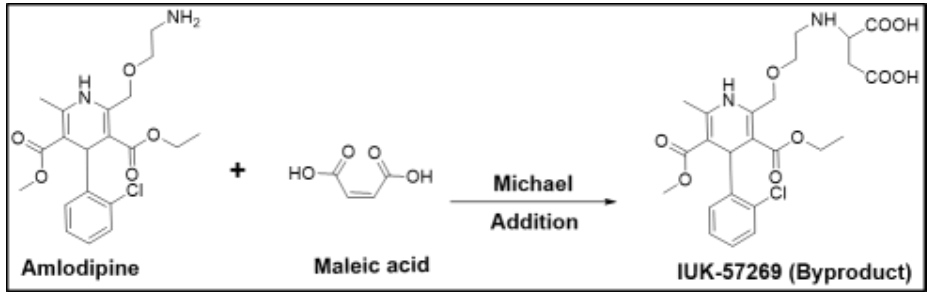
Figure 1. Degradation reaction of amlodipine in the presence of maleic acid.